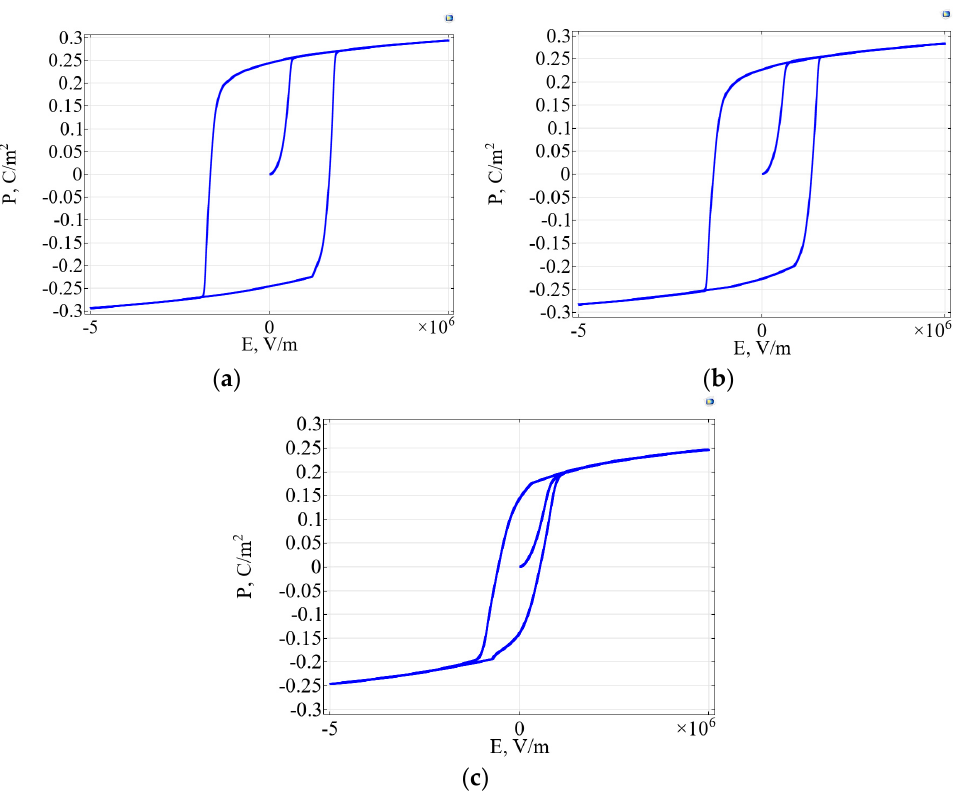
Figure 5. The polarization–electric field dependencies calculated at different values of the temperature: ( a ) T = 278 K, ( b ) T = 293 K, ( c ) T = 353 K. Table 2. The remanent polarization P r and the coercive field E c under variation of sample thickness.